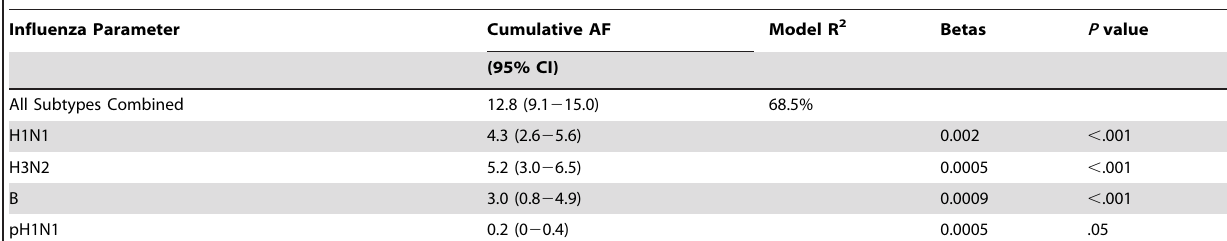
Table 1. Modeling